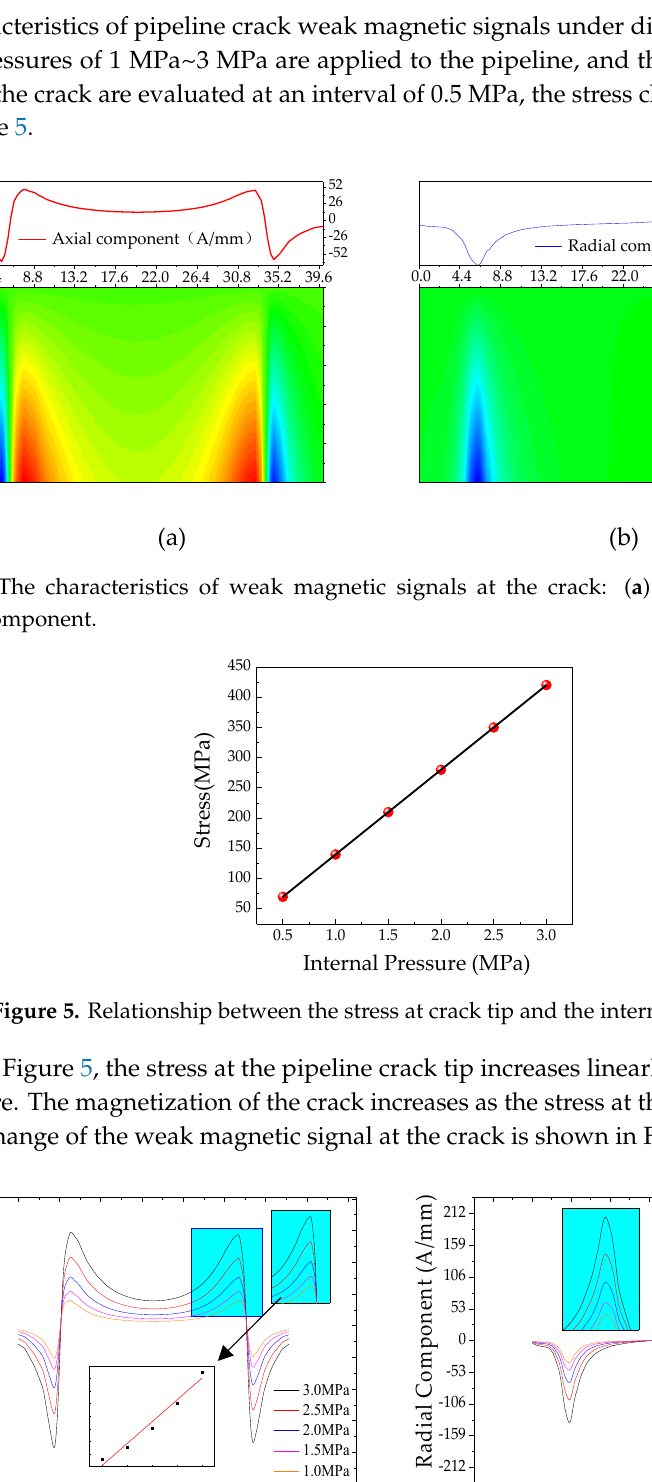
Figure 3. The stress diagram of pipeline crack.